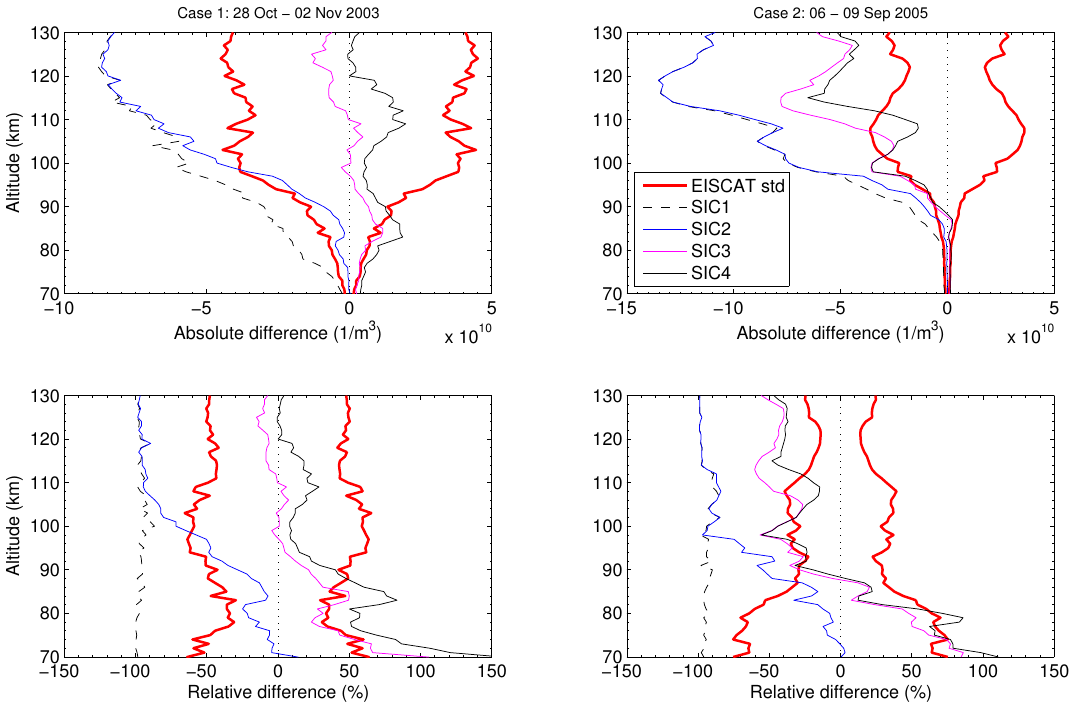
Figure 7. Top: absolute difference of the median electron concentration of the four SIC runs and EISCAT observations. The thick red line indicates the median of EISCAT standard deviation, while zero indicates the median of the EISCAT measurements. Bottom: the same, but as relative difference to the median EISCAT electron concentration.